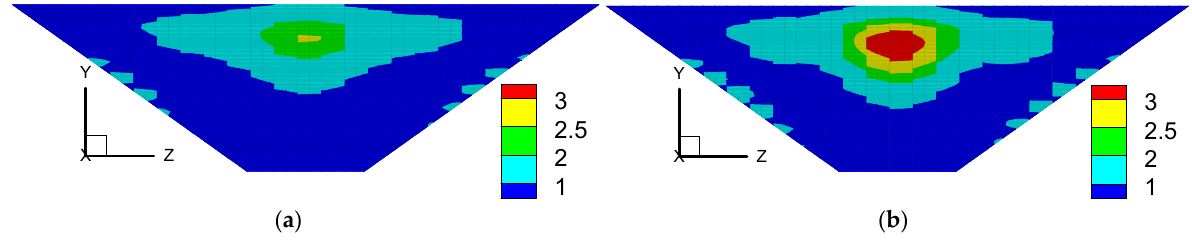
Figure 24. Maximum distribution of concrete face slabs’ compressive stresses along the dam axial direction (MPa): ( a ) Neglecting hydrodynamic pressure and ( b ) the Polyhedron SBFEM.